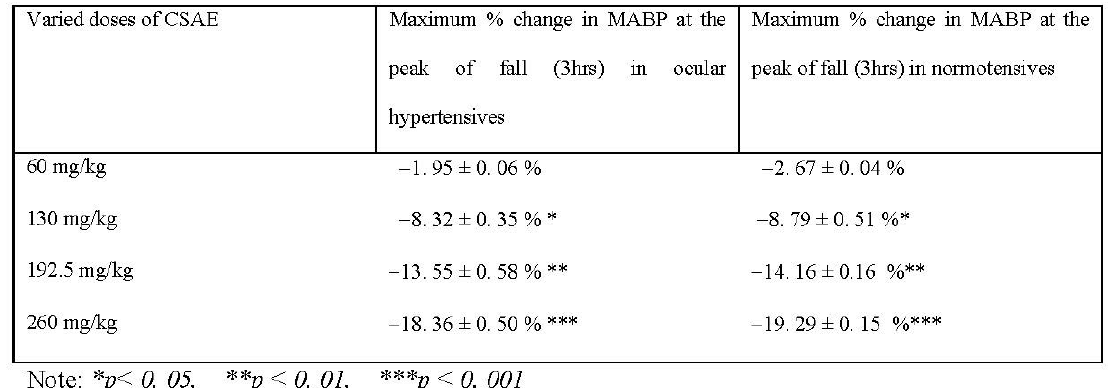
Table 3 : Maximum percentage changes in MABP with varied doses of CSAE compared to water (control) in ocular hypertensives and normotensive